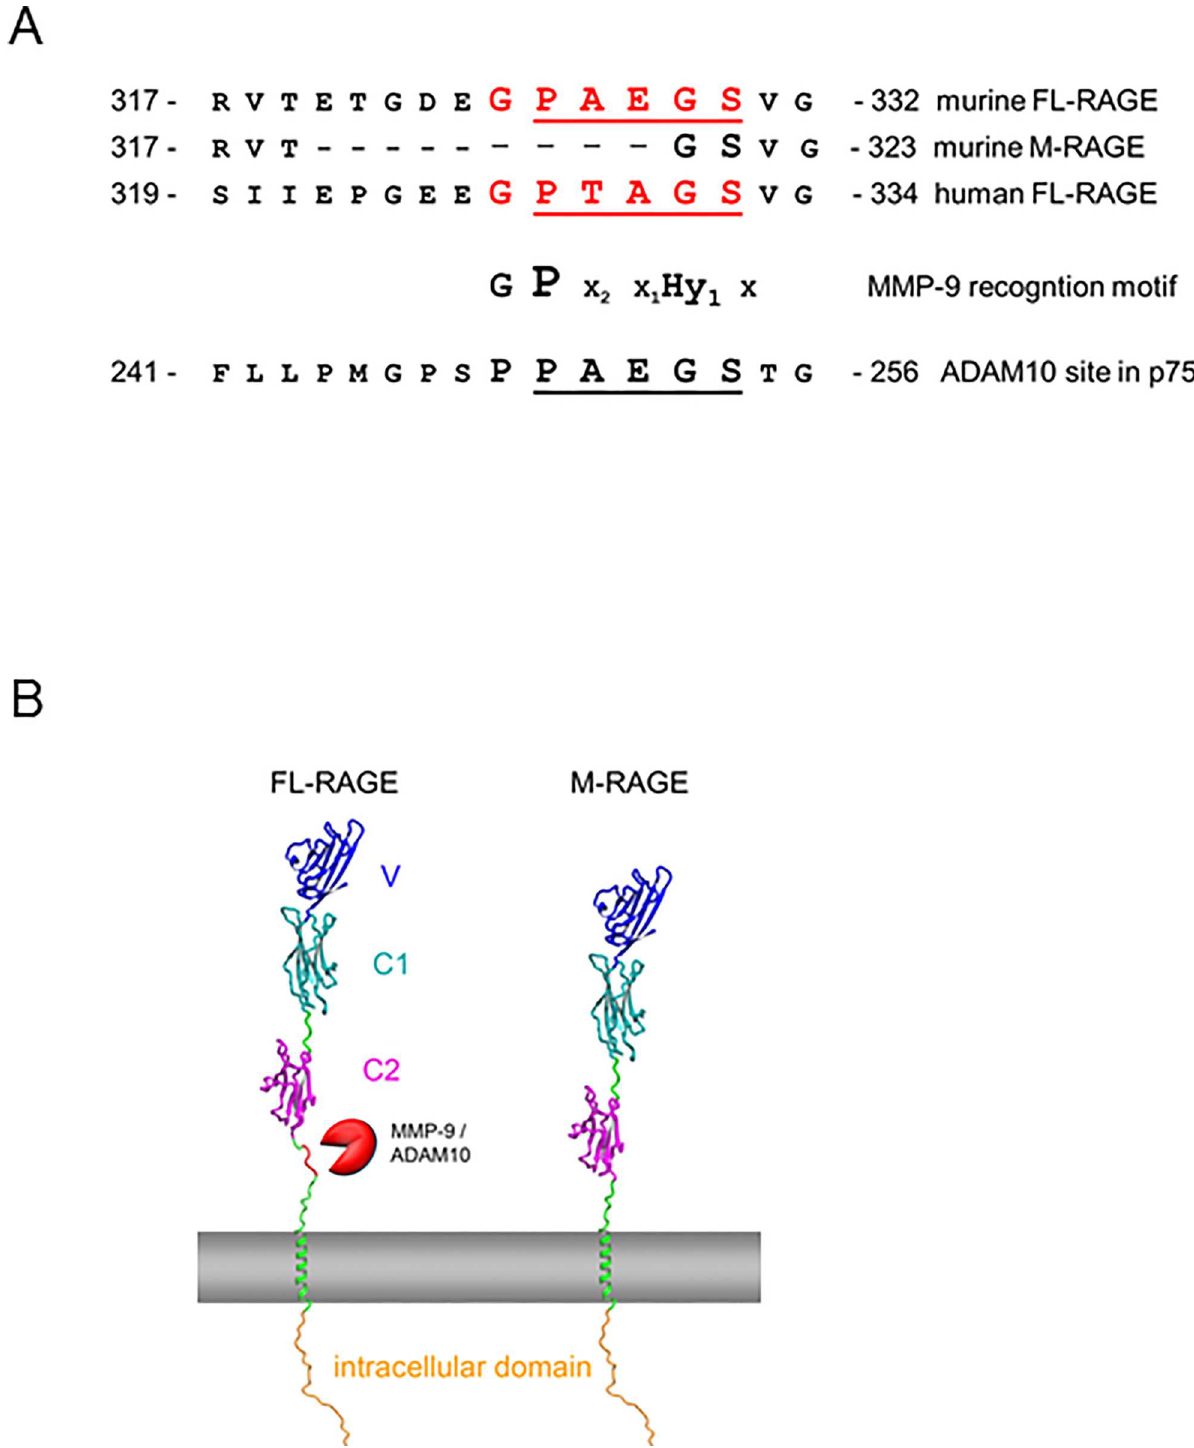
Fig 3. M-RAGE lacks a protease recognition site. (A) Sequence alignmentof murine FL-RAGE and M-RAGE with human FL-RAGE. M-RAGE lacks nine amino acid residues relative to FL-RAGE. This stretch of residues comprises an MMP-9 recognitionsite (red) that overlaps with a motif recognizedby ADAM10 protease (underlined). (B) Three-dimensional models of FL-RAGE and M-RAGE. The three Ig domains of RAGE (V, C1, and C2) are shown in different colors, the transmembrane helix is shown in green and the location of the membrane is indicatedin grey. The protease recognitionsite in FL-RAGE is highlightedin red. Clearly, in FL-RAGE the linker between C2 and the transmembrane helix is extended and more easily accessibleby proteasessuch as MMP-9 or ADAM10. doi:10.1371/journal.pone.0153832.g003 PLOS ONE | DOI:10.1371/journal.pone.0153832 September 21,